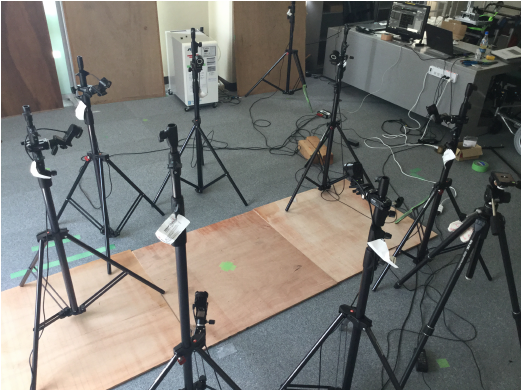
Figure 6. Measurement environment of motion capture system (adapted from [18]).